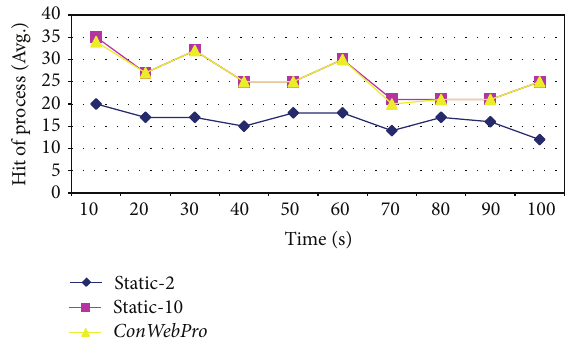
Figure 10: The average hit of request at Clark Net web